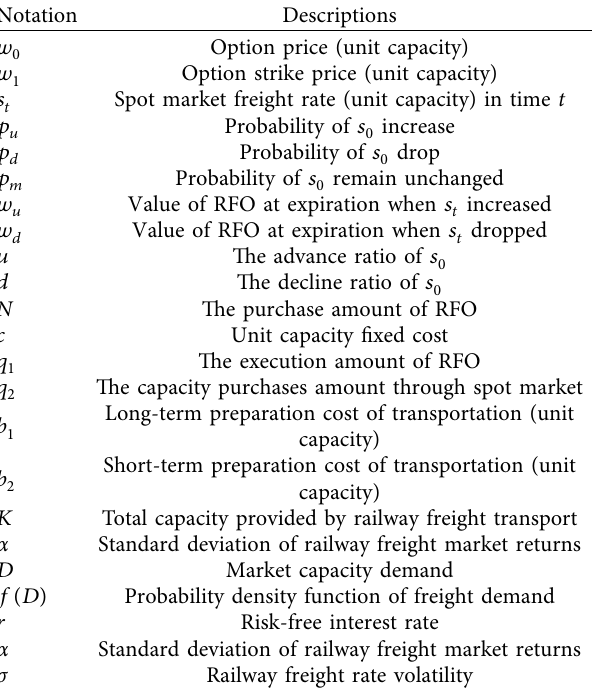
Table 1: Summary of